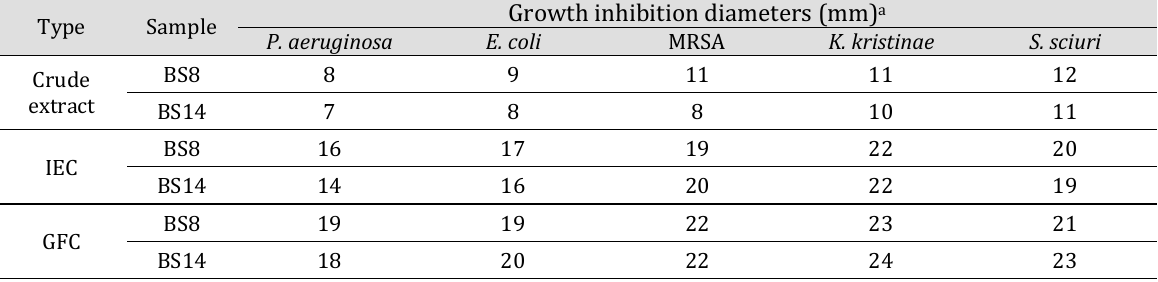
Table 7. Growth inhibition diameter induced by bacterial secondary metabolites crude extracts (without purification) and after Ion Exchange Chromatography (IEC) and Gel Filtration Chromatography